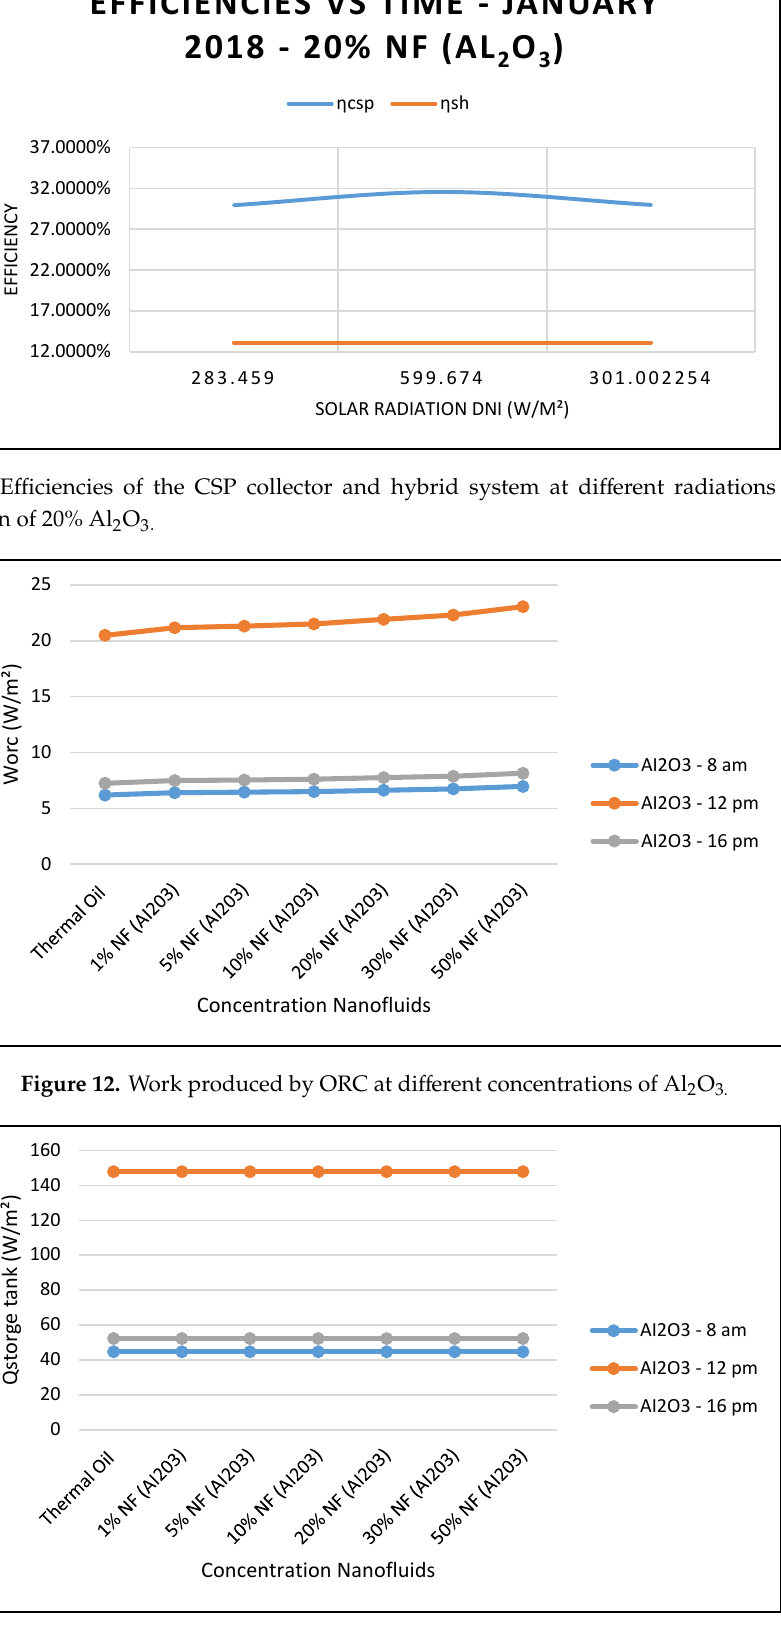
Figure 13. Thermal energy storage at different concentrations of Al 2 O 3 .